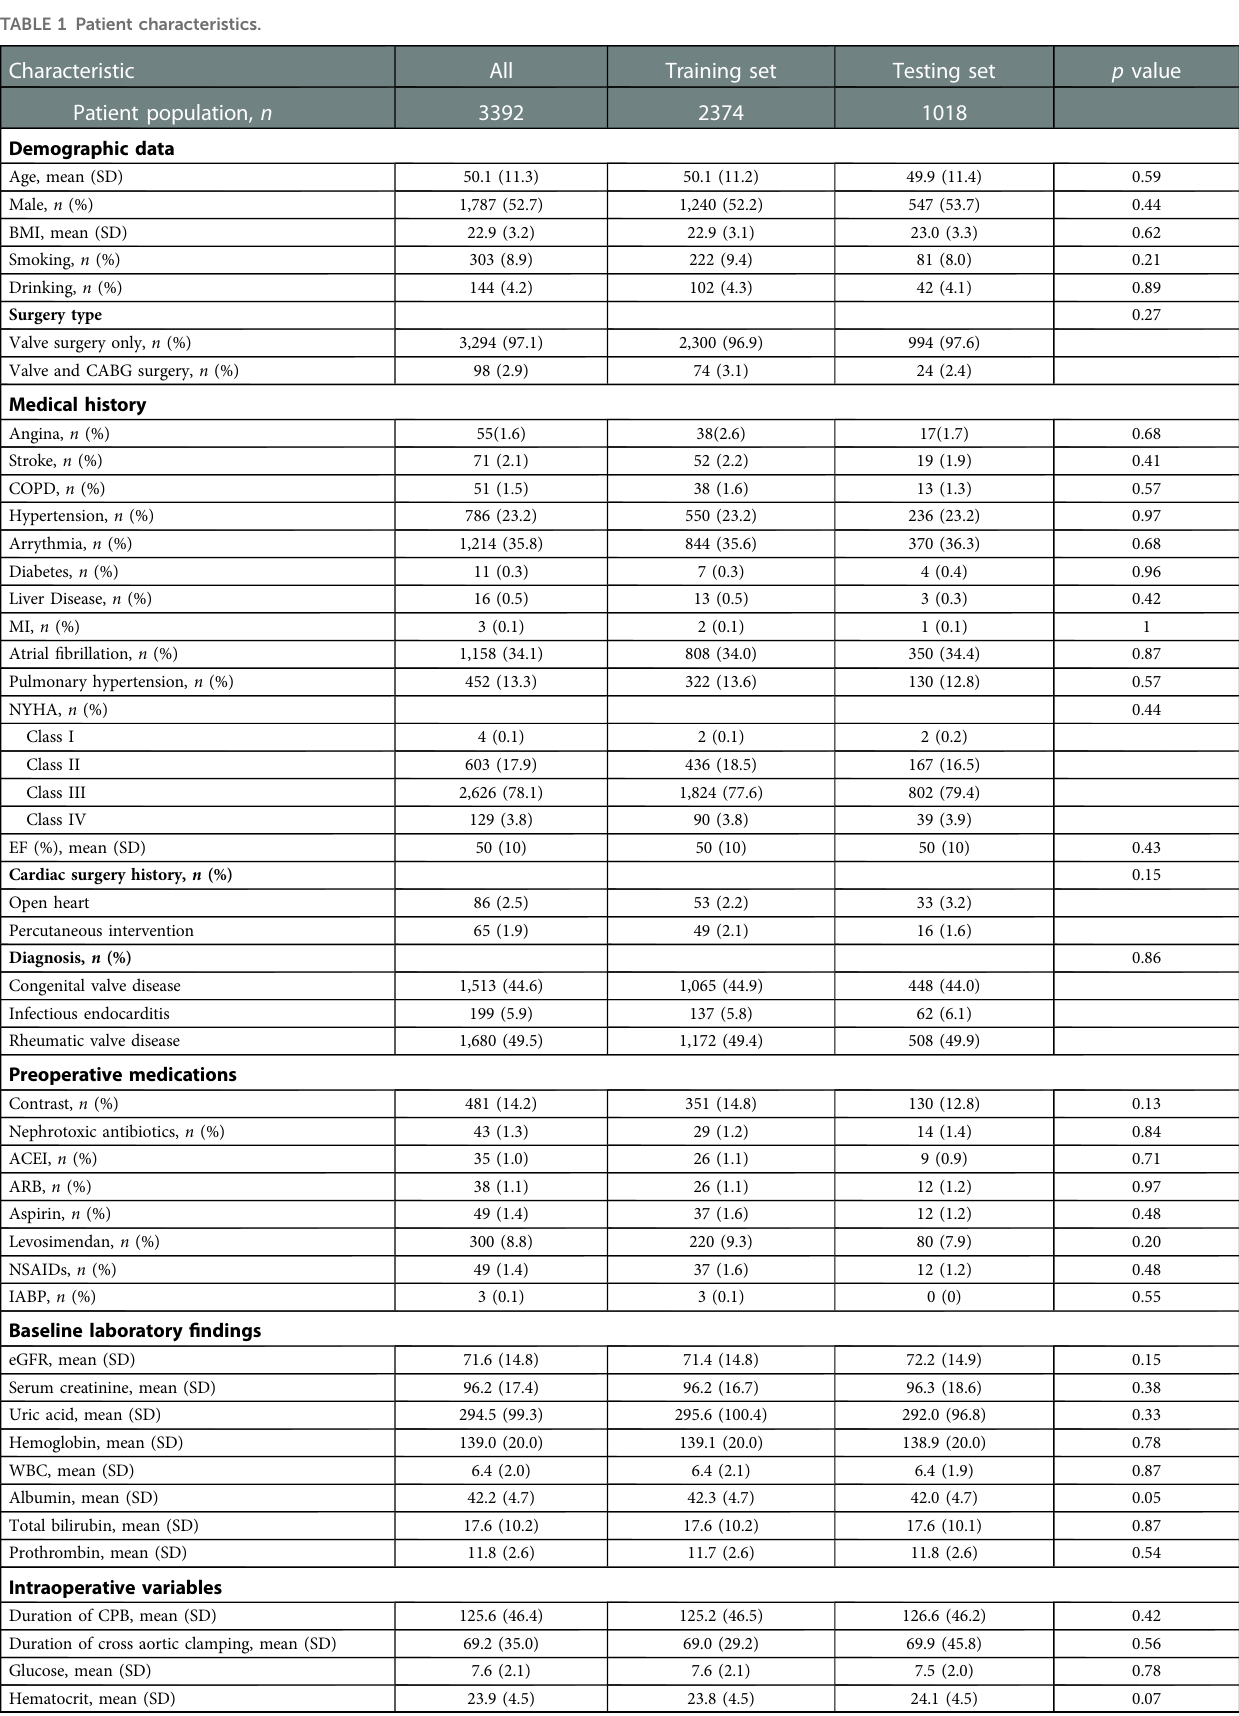
TABLE 1 Patient